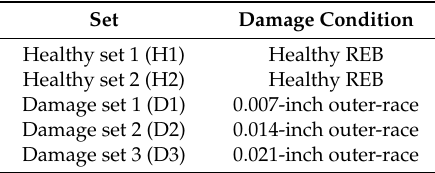
Table 2. REB conditions for Case